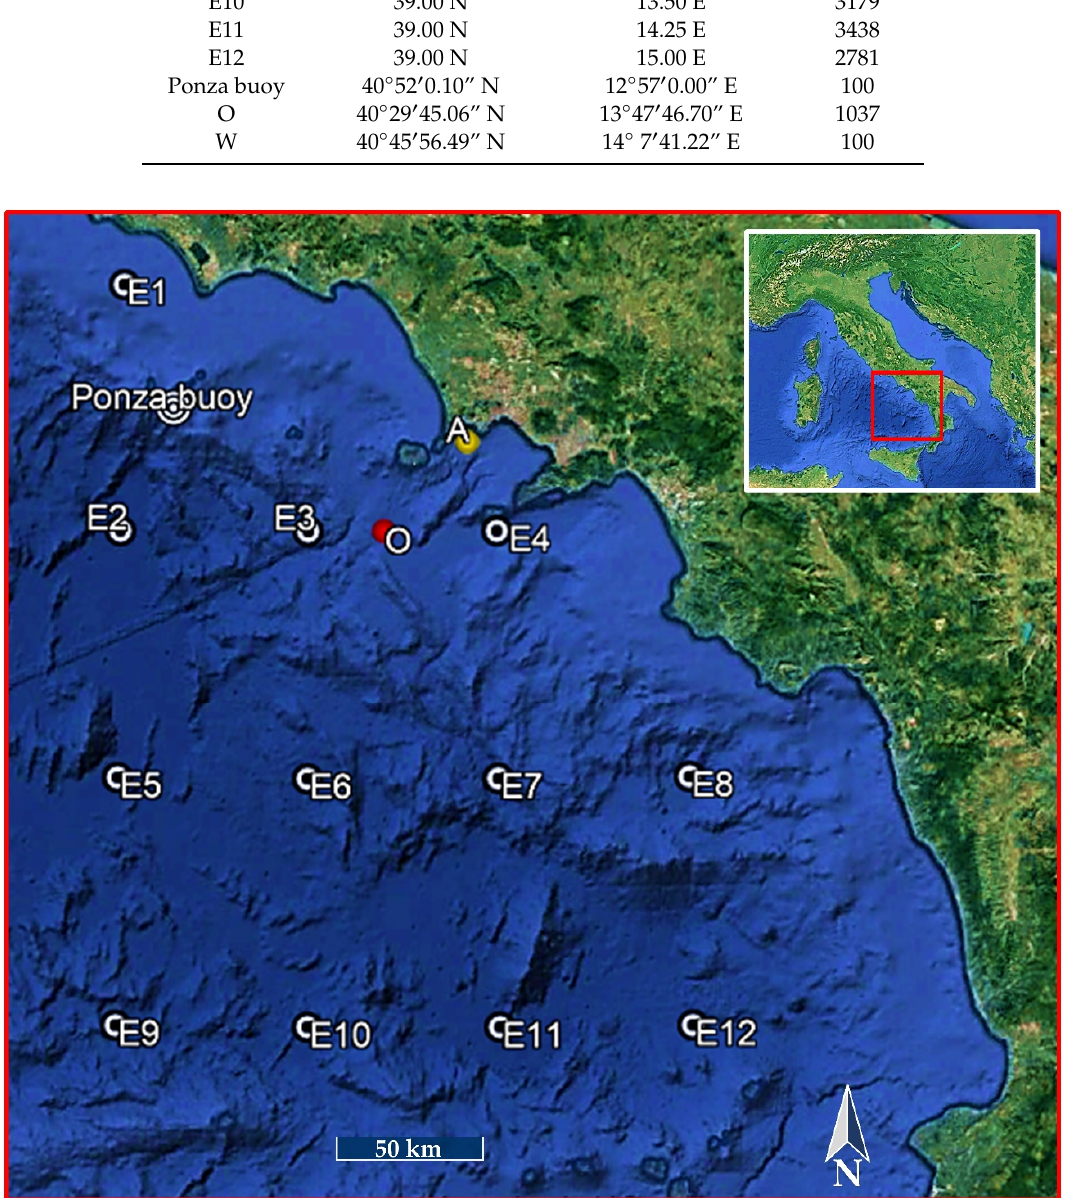
Figure 1. Map of mid-Tyrrhenian Sea, showing the location of the Ponza wave buoy, European Centre for Medium-Range Weather Forecasts (ECMWF) grid points E1–E12 and reference point O (offshore of the Gulf of Naples) and point W (offshore Pozzuoli’s Gulf). Table 1. Geographical information of ECMWF grid points E1–E12, Ponza wave buoy and reference point O (offshore of the Gulf of Naples) and point W (offshore Pozzuoli’s Gulf).